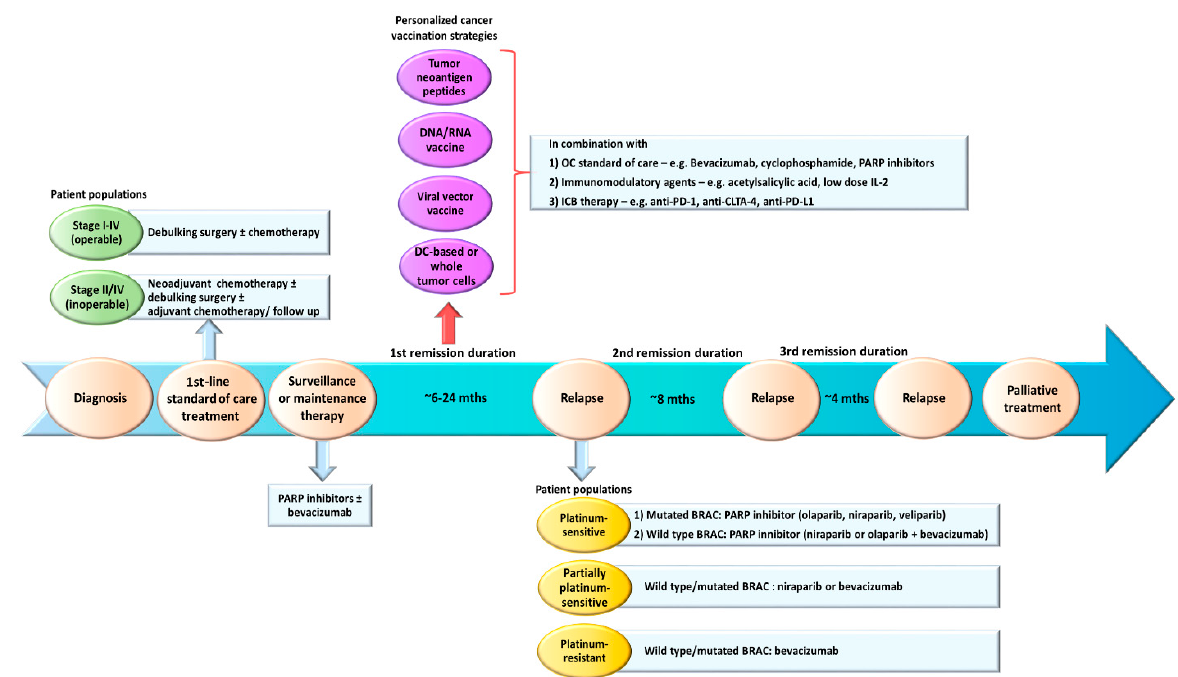
Figure 1. An overview of the general standard-of-care treatments in OC and proposed personalized cancer vaccination strategies in the first remission after first-line treatments. After diagnosis, OC patients with operable diseases will undergo debulking surgery and chemotherapy. Patients with early stage I disease usually have a good outcome after first-line treat- ments. Patients who are inoperable (e.g., old age, poor health or extensive metastasis) will receive neoadjuvant chemotherapy, and if downstaged sufficiently, can be assessed for a debulking surgery with subsequent adjuvant chemotherapy. Then, advanced stage III and IV patients will be offered maintenance therapy consisting of PARP inhibitors ± bevacizumab. Most patients will relapse within 24 months after the first-line treatment (first remission). Based on their responsiveness to platinum chemotherapy and BRCA (wild type/mutated) status, they will be stratified to received different types of PARP inhibitors or bevacizumab. We proposed to introduce personalized cancer vaccination strategies (e.g., tumor neoantigen peptides, DNA, RNA or viral vector vaccines, DC-based or modified whole tumor cell vaccines) during the first remission when the patients are presented with minimal disease (i.e., complete respond (CR) or no evidence of disease (NED)) after first-line treatments. OC standard of care, such as bevacizumab, cyclophosphamide and PARP inhibitors can potentially be incorporated in the strategy. In addition, ICB therapy (e.g., anti-PD-1, anti-CTLA-4 and anti-PD-L1) and other immunomod- ulating agents (e.g., acetylsalicylic acid and low-dose IL-2) can be considered to help augment vaccine-primed antitumor T cell responses and modulate the OC